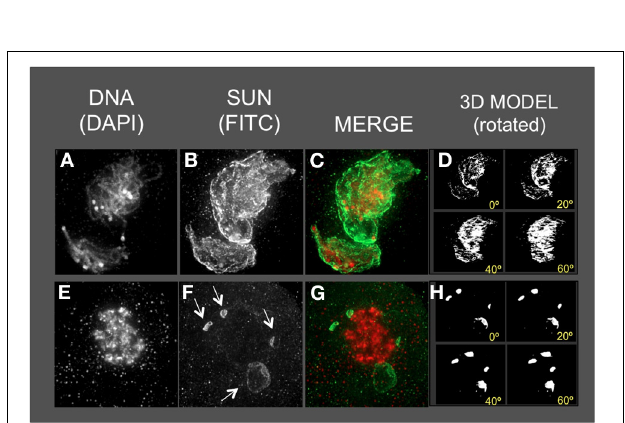
FIGURE 7 | The maize SUN2 in as1/as1 meiotic cell nuclei. Two representative nuclei (A–D , E–H) from cells fixed and stained as described in the legend for Figure 2 . DAPI (total DNA, red) and FITC (SUN, green) images are shown along with projections/3D models of the FITC images viewed as rotations about the Y axis (D,H) .